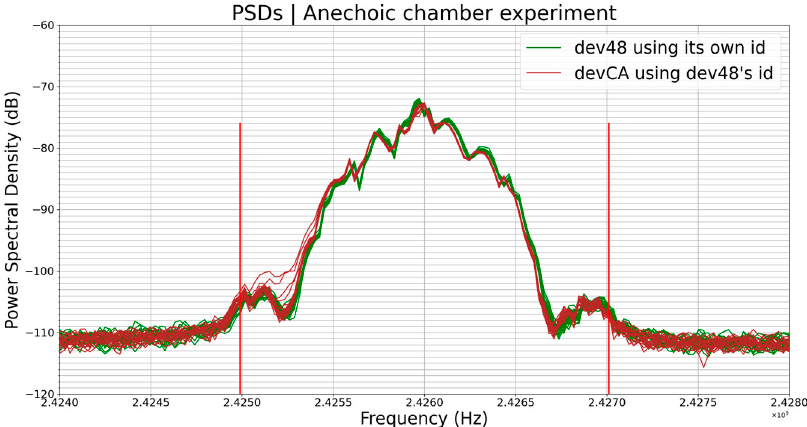
Figure 10. PSDs of dev48 (green plots) and devCA (brown plots) devices using the same identifier (the one of dev48) and, thus, always transmitting exactly the same data.